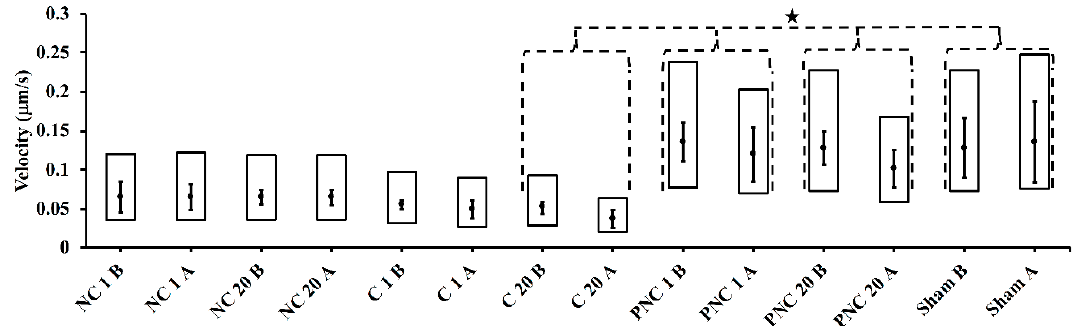
Figure 6. Track velocities for each condition tested are shown before and after exposure in box plots. The star shape ( (cid:70) ) denotes a statistically significant difference according to the K-S test at alpha = 0.01 compared to pre-exposure. Error bars represent one standard deviation from the cell-to-cell mean value.